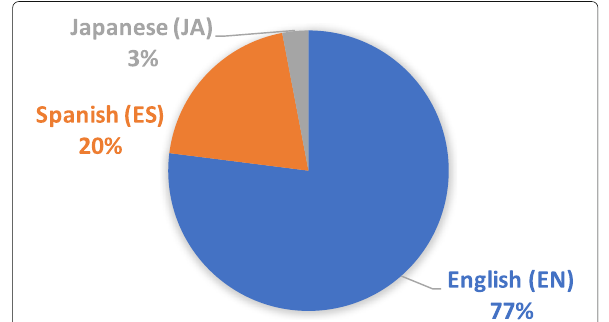
proposed dataset contains audio tracks in three different languages, namely English, Spanish, and Japanese. All the original audio signals are normalized to an average loud- ness being − 27 LKFS ± 2 LU dialog-gated via the Dolby Professional Loudness Metering (DPLM) tool. The lan- guage distribution is shown in Fig. 2. The name of the episode/TV show for each sample remains unpublished. However, each sample has both a show ID and a season ID to help users identify the connection between the sam- ples. For instance, two samples from different seasons of the same show would share the same show ID and have different season